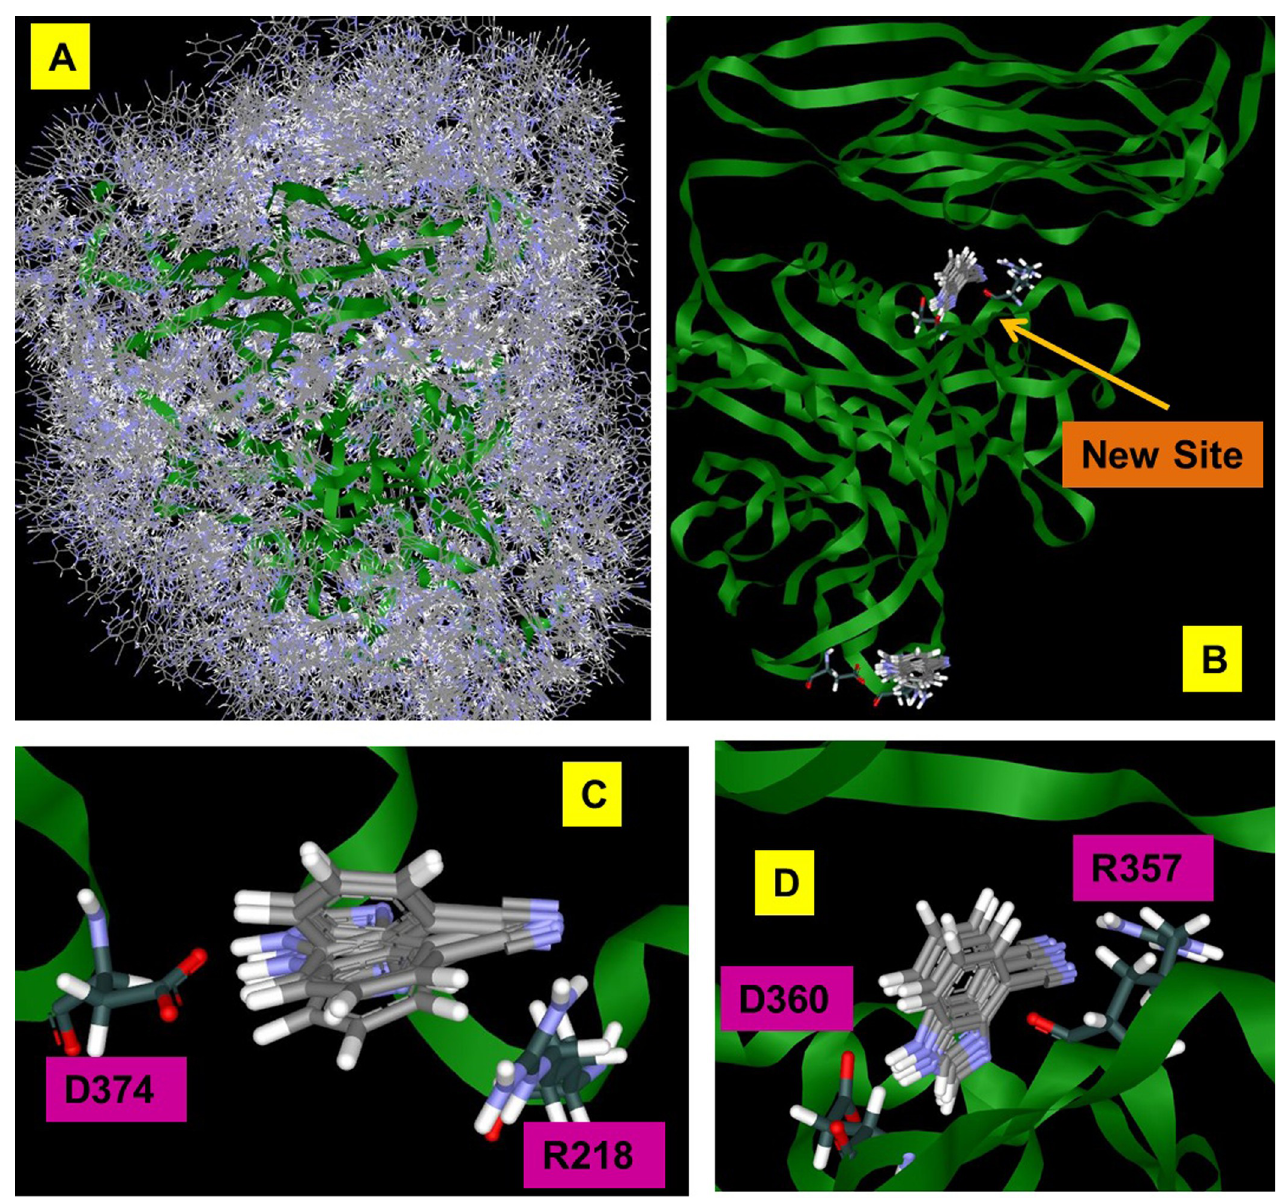
Fig 7. SACP on PCSK9 with cyano-benzimidazole. The high chemical potential (A) and lowest chemical potential (B) simulations identify the known high affinity (C) Y306 LDLR binding site and a (D) new site.